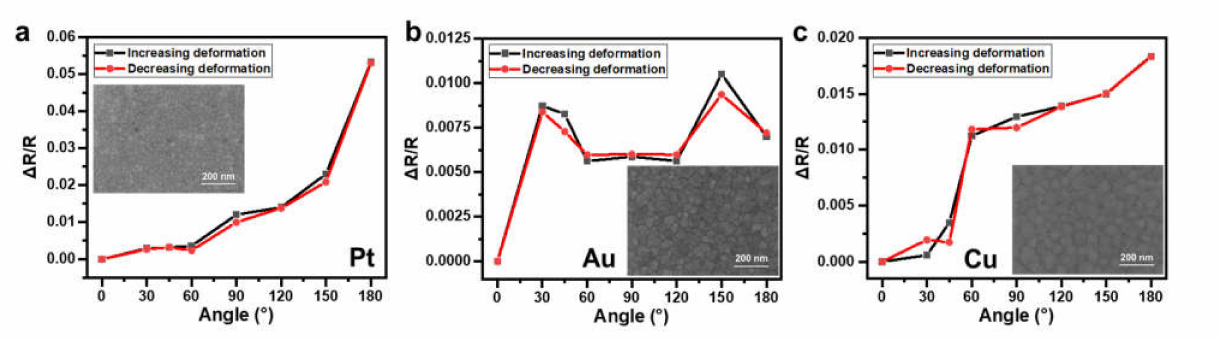
Figure 6. Relative resistance changes in response to the angles of sensors constructed with ( a ) Pt, ( b ) Au, and ( c ) Cu. Inset: SEM images of the surface morphology of corresponding metal